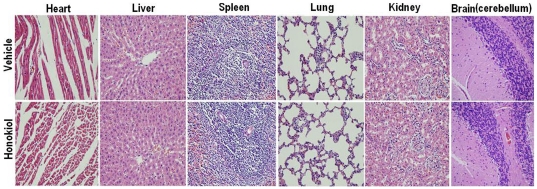
Histological staining of organs of rats with vehicle and high-dose honokiol.Rats were injected via caudal vein at a dose of 80 mg/kg body weight once a day for 14 days.